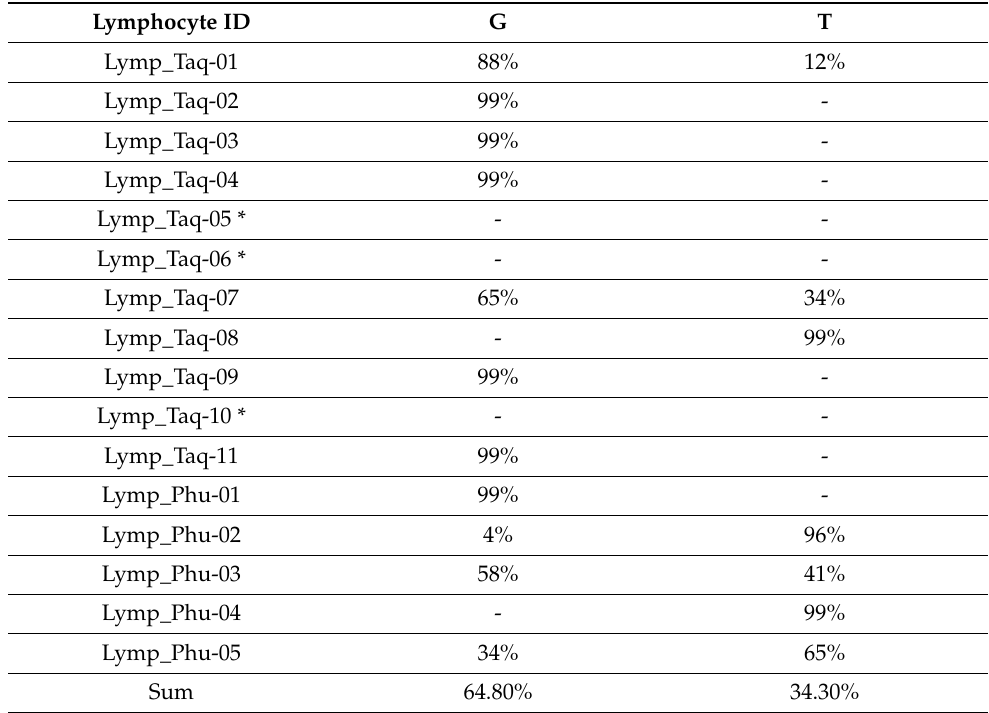
Table 6. Summary of the genotypes of the 13 sequenced single lymphocyte